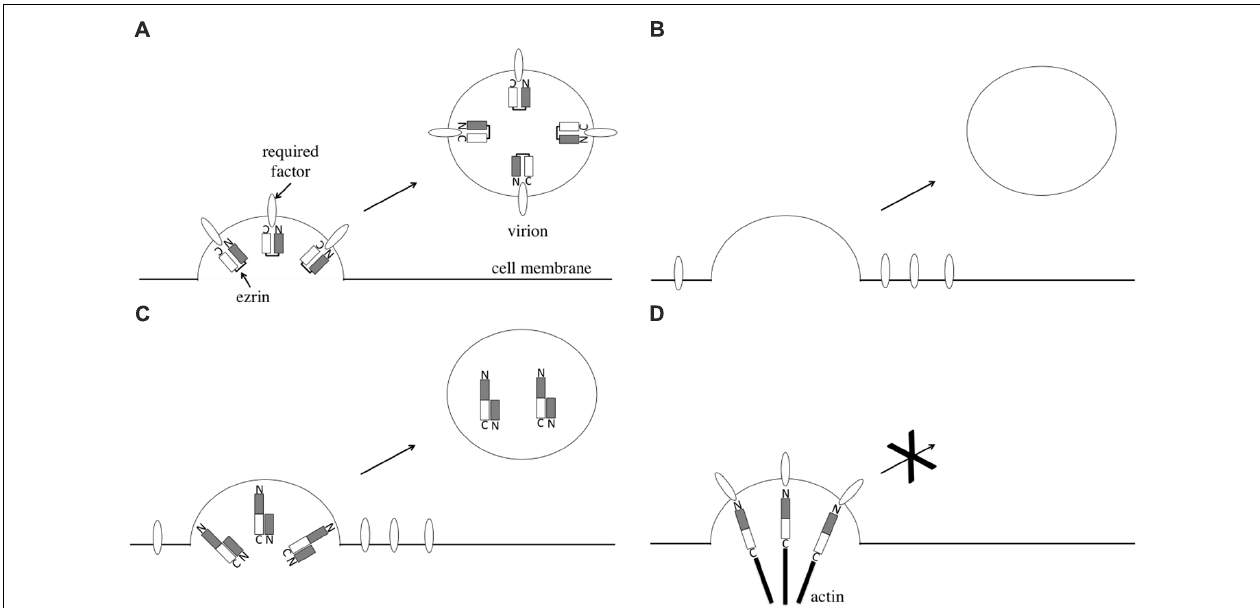
FIGURE 8 | Speculated model of ezrin in HIV-1 virion production. HIV-1 virion formation in control cells (A) , ezrin-silenced cells (B) , EZ-N-expressing cells (C) , and EZ-TD-expressing cells (D) are indicated.